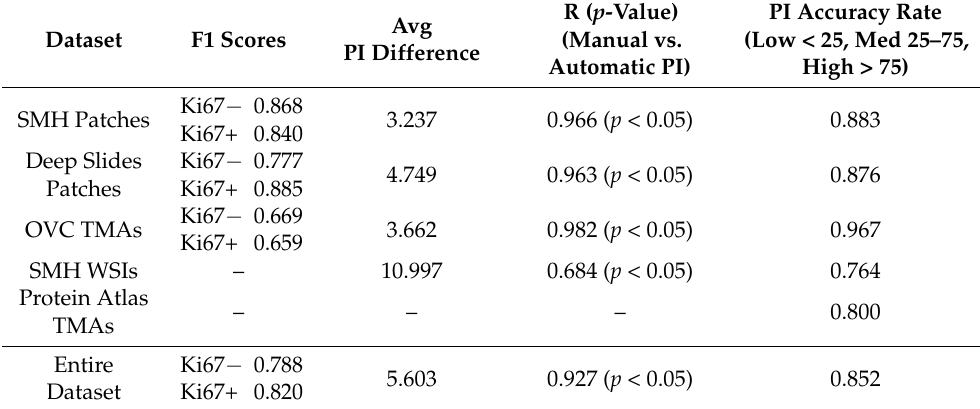
Table 7. PI accuracy of piNET on diverse data.